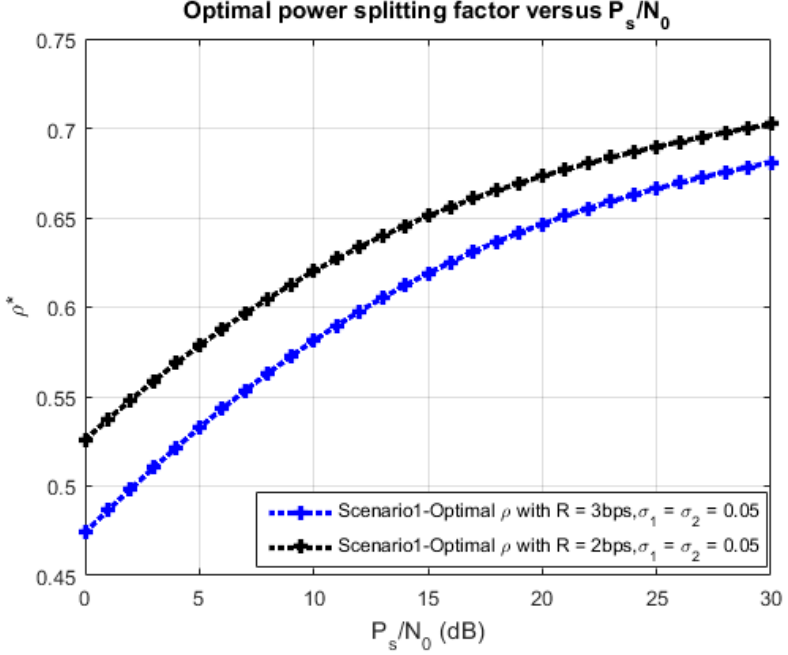
Figure 11. The optimal PS factor versus P s / N 0 for the first case.